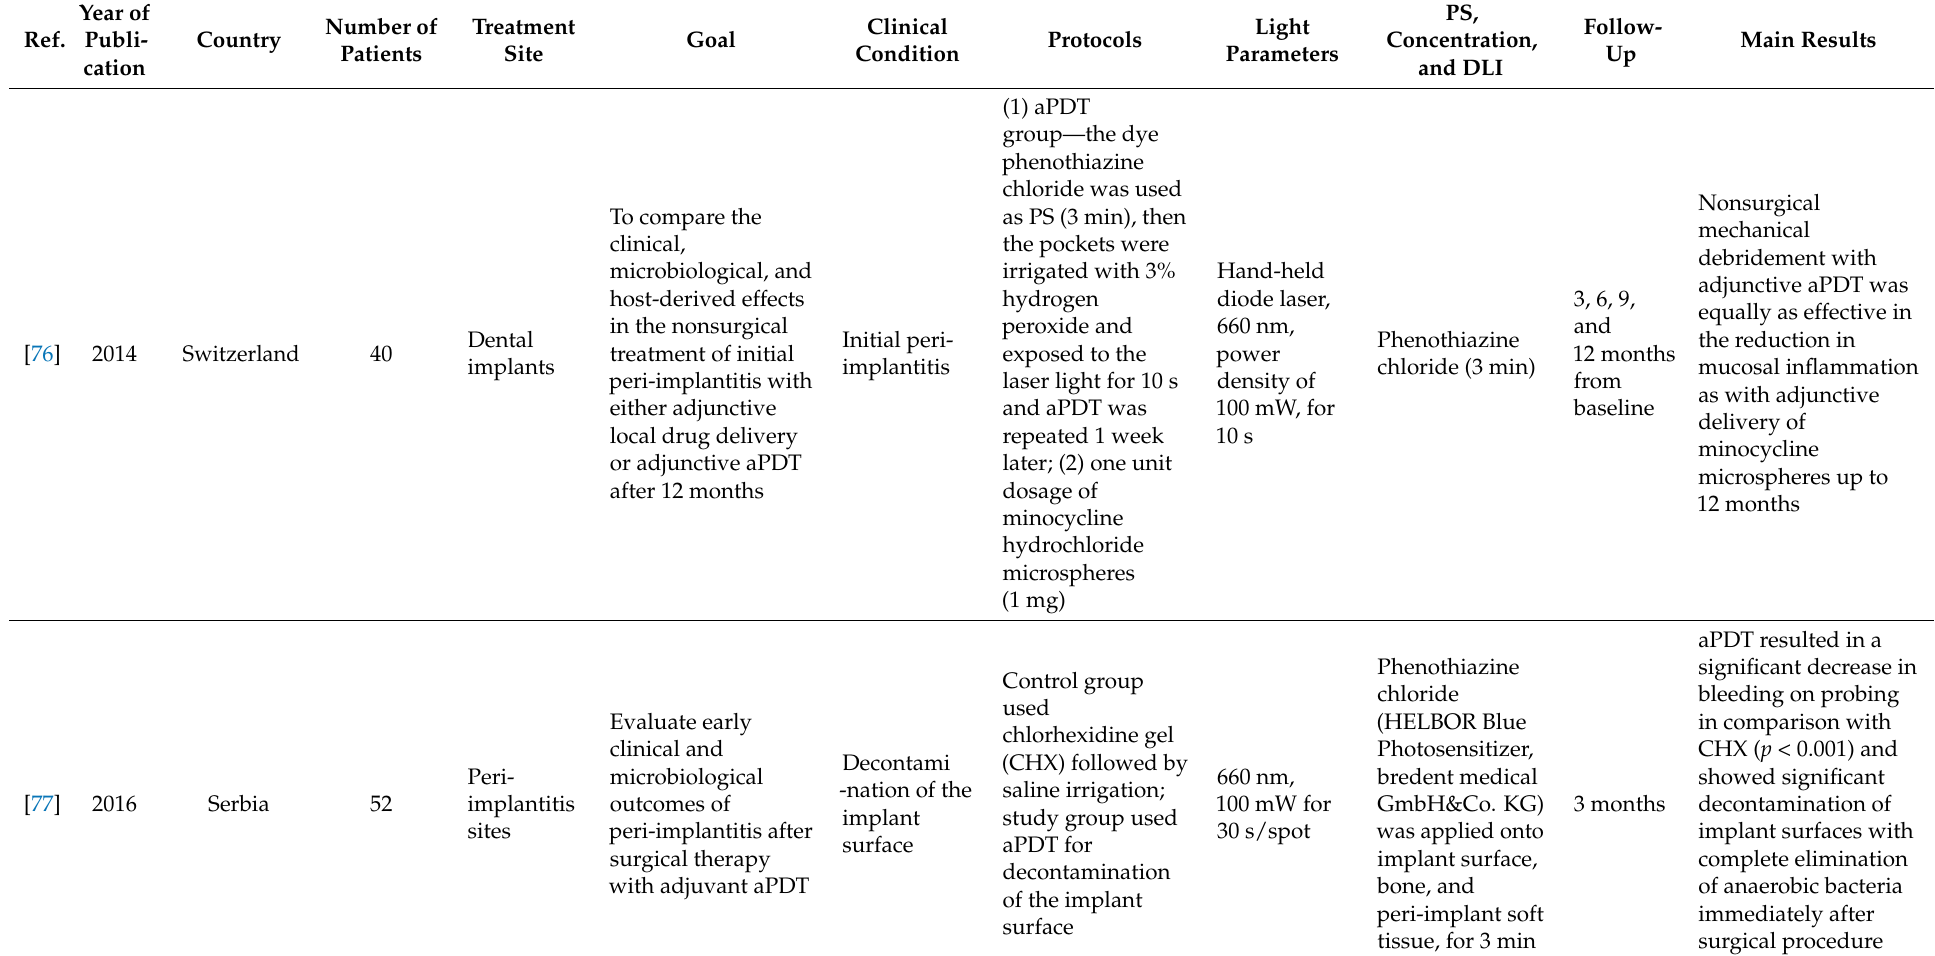
Table 3. Randomized clinical trials that evaluated aPDT for the treatment of peri-implantitis.